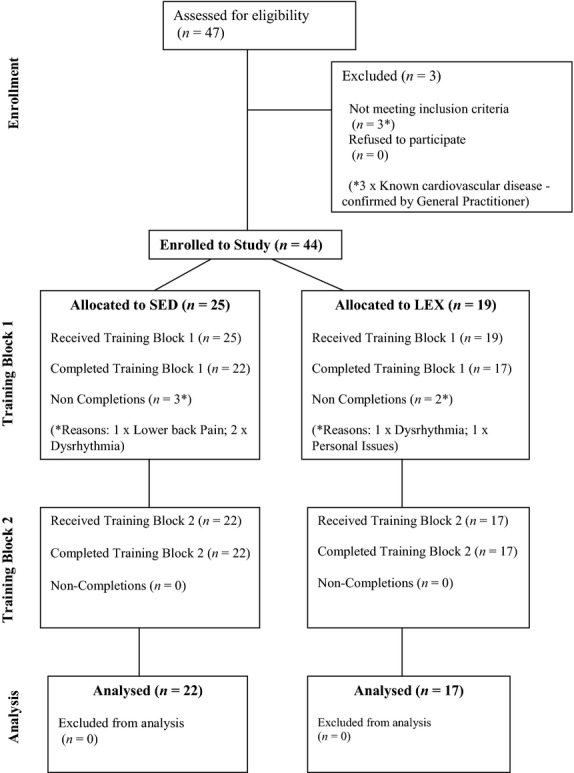
Flow diagram depicting transit of lifelong sedentary (SED) and lifelong exercising (LEX)
participants through the study.